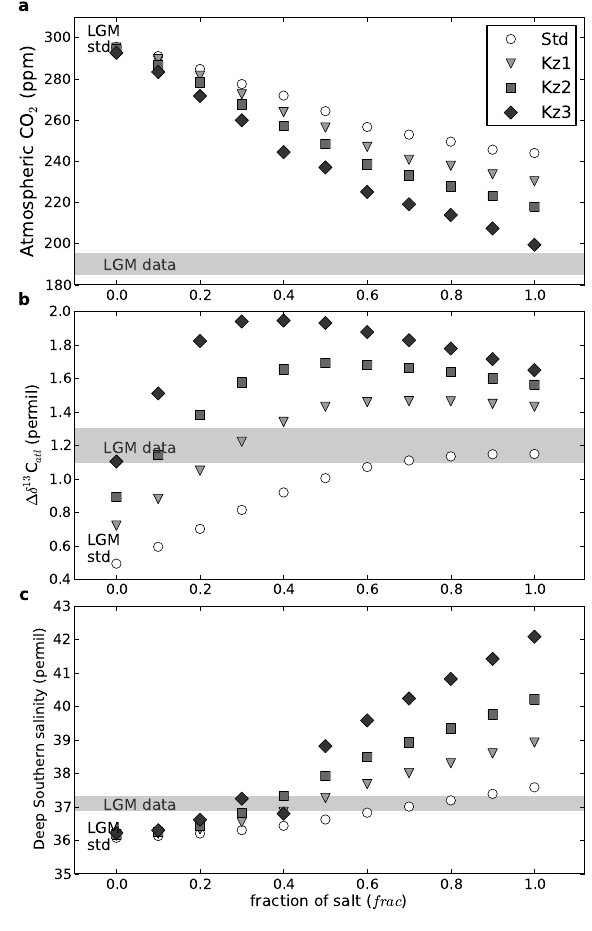
Fig. 8. (a) Atmospheric CO 2 concentration, (b) 1δ 13 C atl (mean upper ( − 2000m to 0m) to deep ( − 5000m to − 3000m) gradient in the Atlantic) and (c) salinity in the deep Southern ocean (Atlantic sector, 50 degrees South, 3626m depth) as a function of the fraction of salt released by sea ice formation used for the brine mechanism (fraction of salt frac , 0 ≤ frac ≤ 1) for different vertical diffusion profiles. Kz0 (grey) is the standard profile, Kz1, 2 and 3 are the tested low diffusion profiles (black). The Last Glacial Maximum (LGM) data are from Monnin et al., 2001; Curry and Oppo, 2005; K¨ohler and Bintanja, 2008; Adkins et al., 2002.